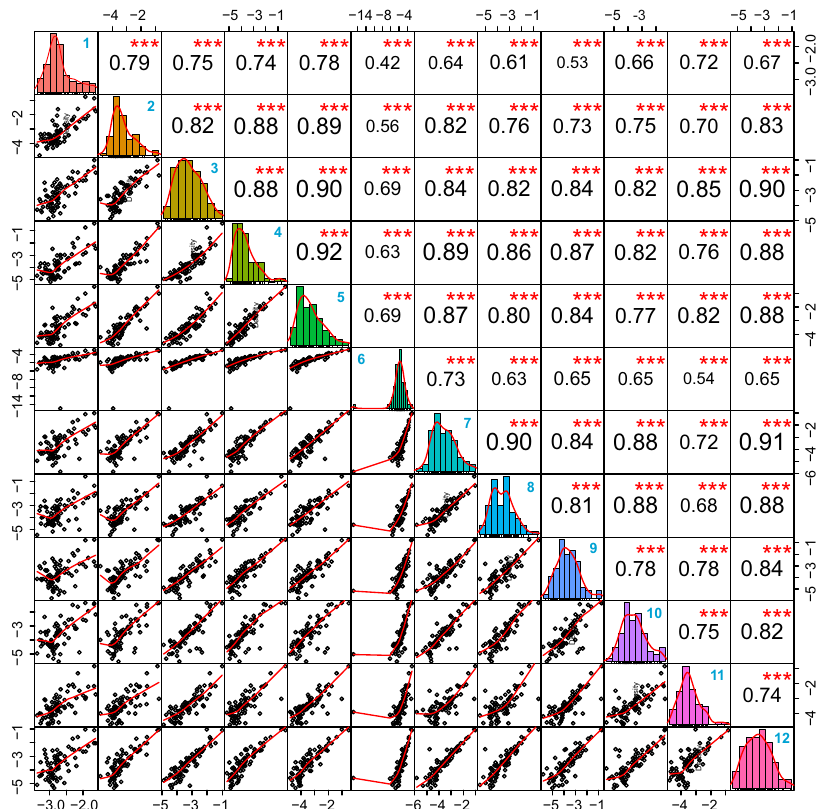
Fig. 4 | Pearson correlations of protein intensities across 12 cores based on 73 shared proteins. Mean normalized intensities of three technical replicates for each corewere used for correlation analysis. The correlation coef fi cient isgiven in